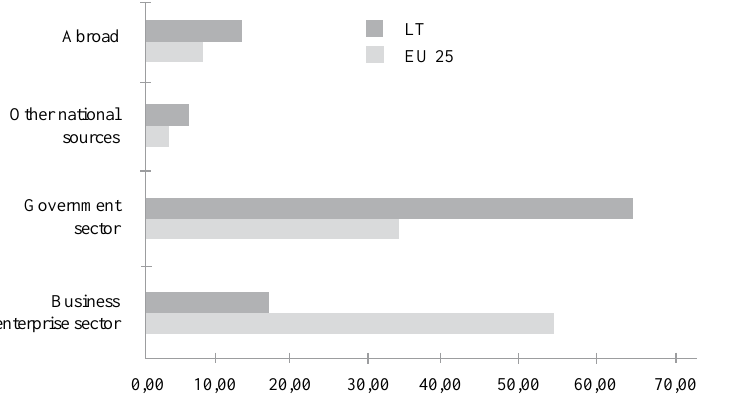
fig. 3. The share of investment in R&D (%) in Lithuania and EU. Source: Eurostat,